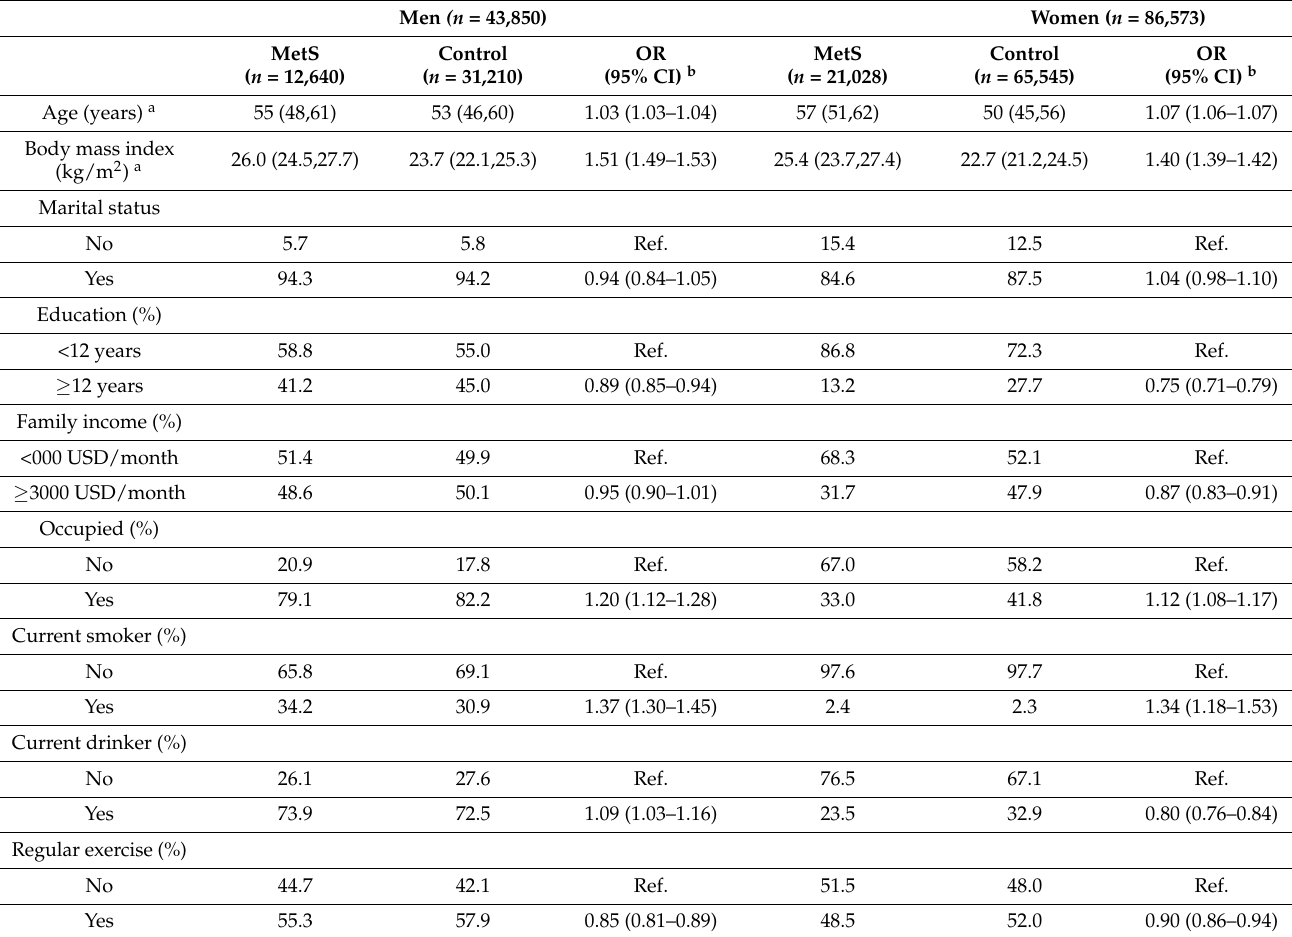
demographic and lifestyle factors of participants according to quartiles of total energy intake are presented in Supplementary Table S1. Table 1. Socio-demographic and lifestyle characteristics according to metabolic syndrome status, the HEXA-G study, 2004–2013.